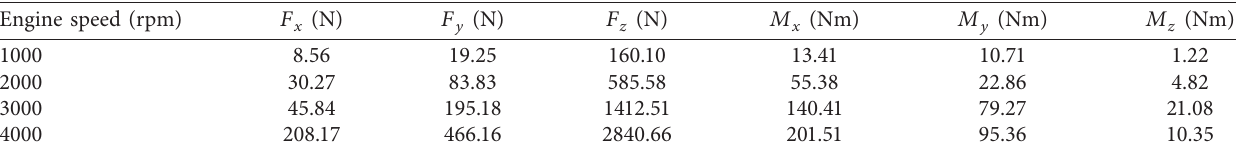
Table 6: Second-order excitation forces identified by the direct method (in the powertrain centroid coordinate system). Engine speed